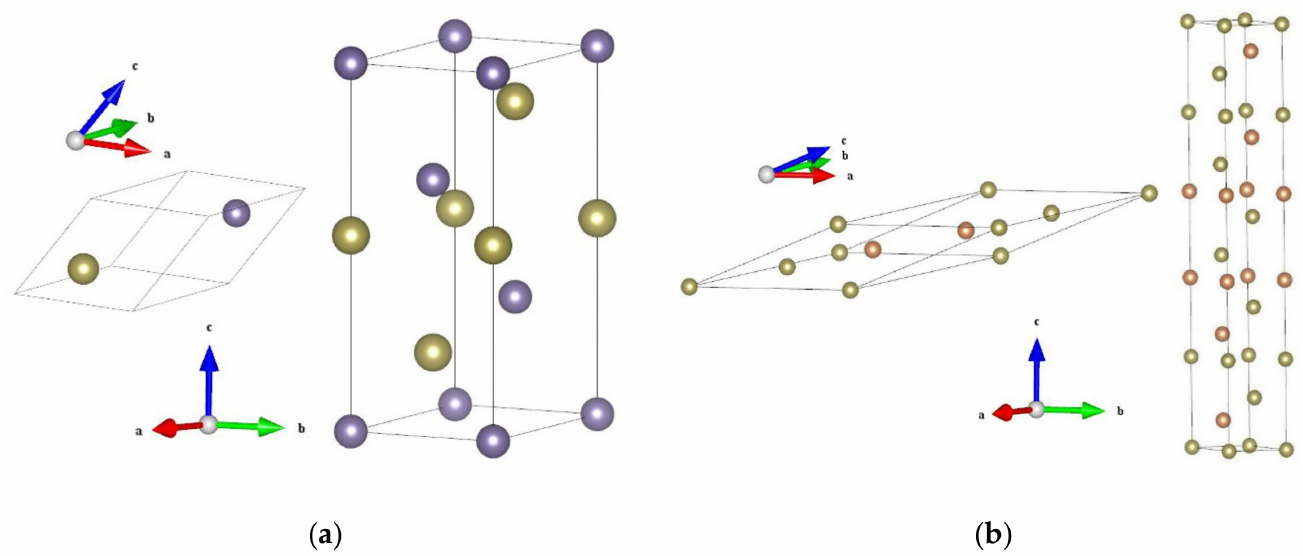
Figure 1. Primitive (left) and conventional (right) cells of ( a ) GeTe and ( b ) Sb 2 Te 3 . The purple, orange and brown balls represent Ge, Sb and Te atoms,